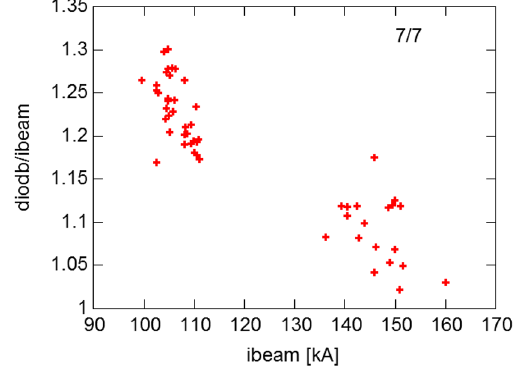
FIG. 15. IBEAM versus the ratio DIODB/IBEAM from 53 7-7 shots. The peak currents are used.